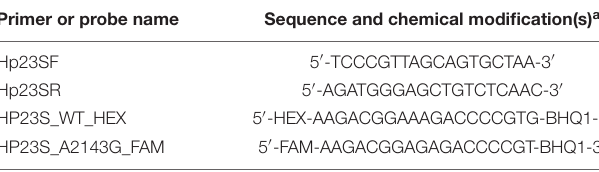
TABLE 3 | Primers and probes used for the ddPCR